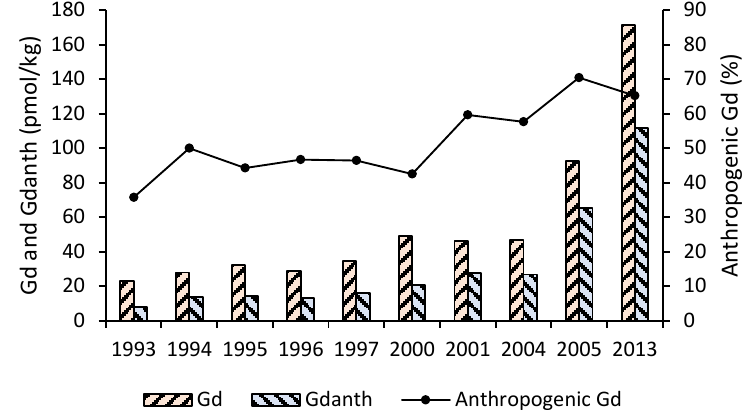
Figure 5. Gd concentration at the Lower South Bay, San Francisco Bay for the period from 1993 to 2013. Water samples were filtered through 0.45-µm membranes and acidified to pH = 1.8 [20].